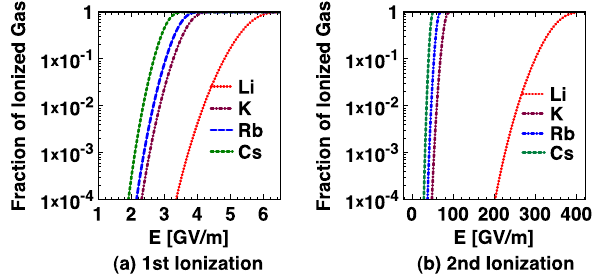
FIG. 2. Fraction of ionized gas vs electric field (assumed to be constant for 50